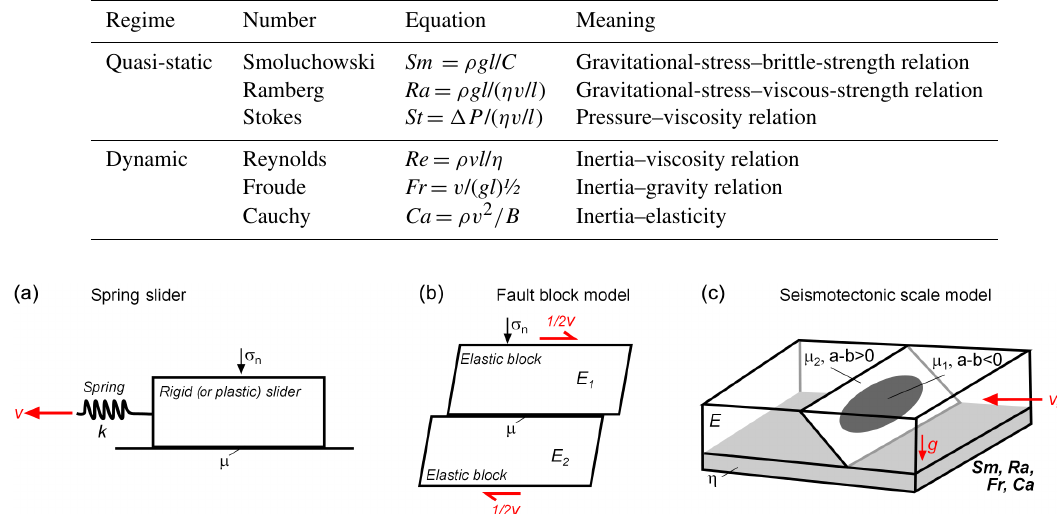
Figure 1. Analogue model categories: (a) spring-slider model ( v is velocity, k is spring constant, σ n is normal load, µ is friction coefficient); (b) fault block model ( E is Young’s modulus); (c) seismotectonic scale model ( a – b is rate–state parameter, η is viscosity, g is gravitational acceleration, F is force, Sm, Ra, Fr and Ca are dimensionless numbers used for scaling; see Table